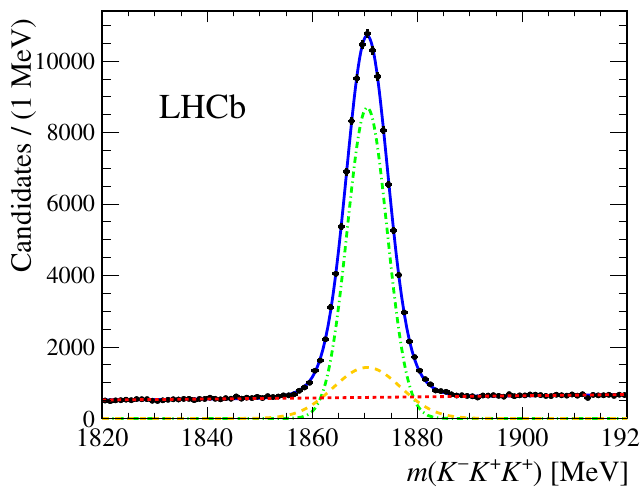
Figure 1 . Invariant-mass spectrum of the K (cid:0) K + K + candidates with the (cid:12)t result overlaid (solid blue line). The orange and green dashed lines indicate the two Gaussian functions representing the signal and the red dashed line is the